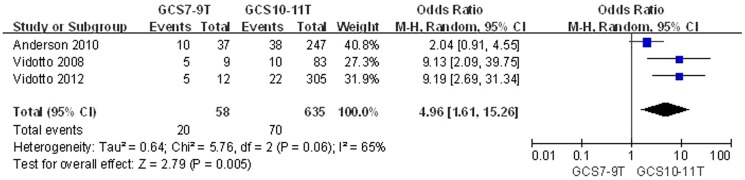
Meta-analysis result of GCS.